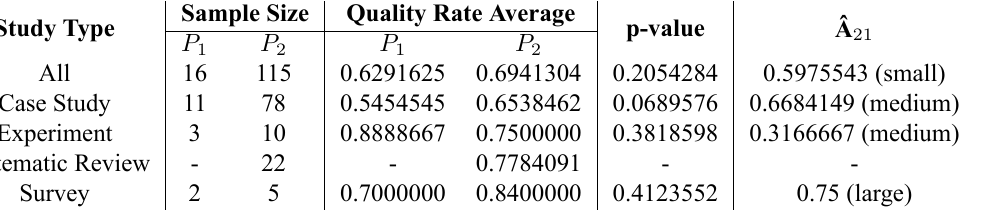
Figure 10. Quality of each empirical studies and systematic reviews performed by year Table 5. Quality rate averages, p-values and effect sizes between P 1 (1998 to 2008) and P 2 (2010 to